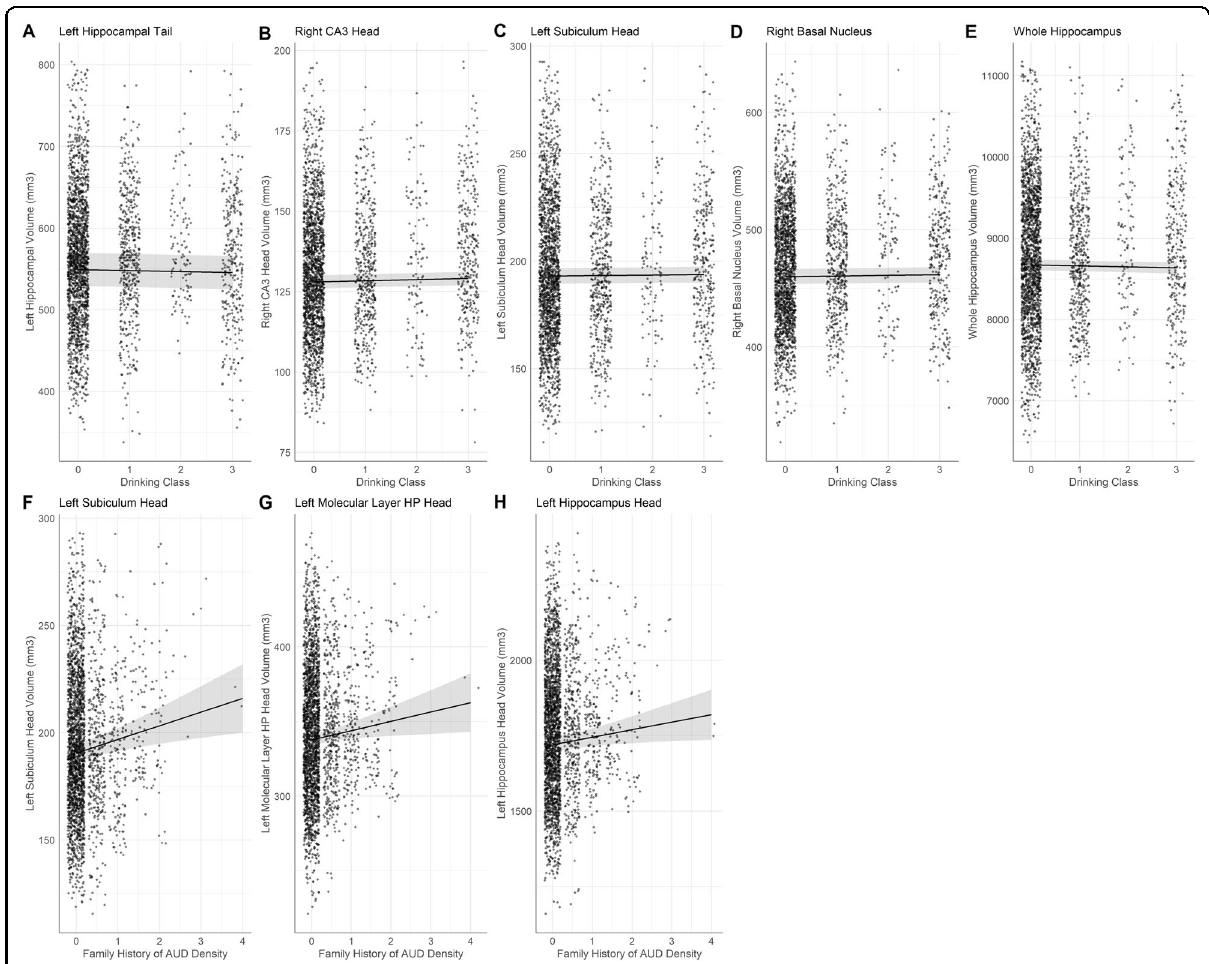
Fig. 1 Conditional main effects of drinking class and family history of AUD. Hippocampal sub fi eld and amygdala nuclei volumes predicted by the conditional main effect of drinking class ( A – D ) and the conditional main effect of family alcohol use disorder density ( F – H ). Whole hippocampus volume predicted by the conditional main effect of drinking class ( E ). Individual data points represent volume at subject scan